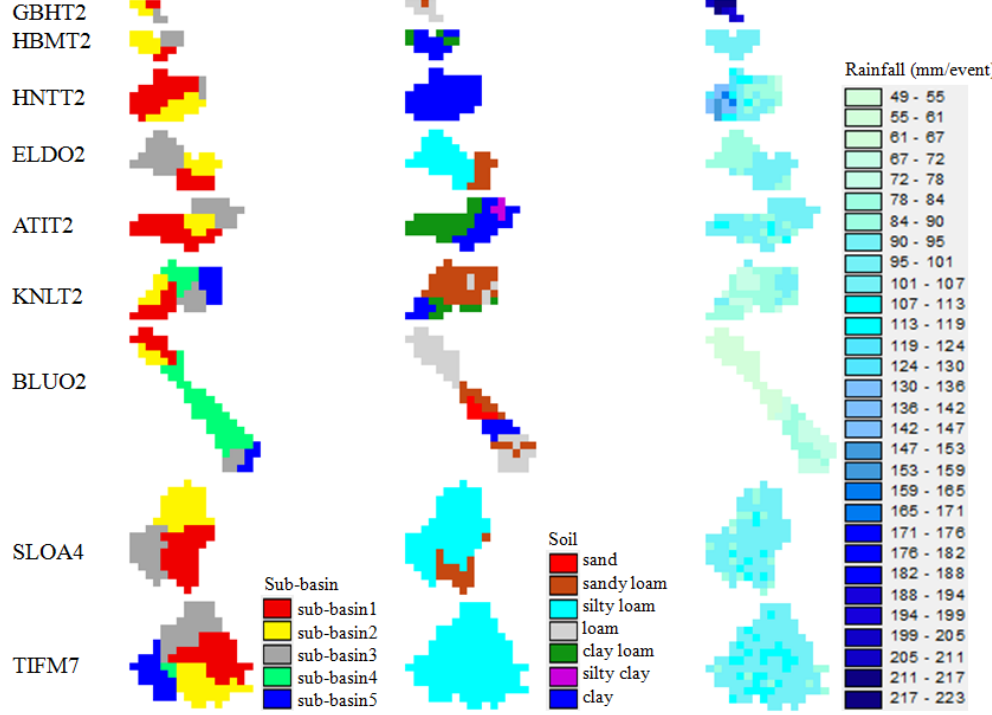
Fig. 3. Map of delineated sub-basins, soil type and mean accumulated rainfall per Fig 3. Map of delineated sub-basins, soil type, and mean accumulated rainfall per event. 810